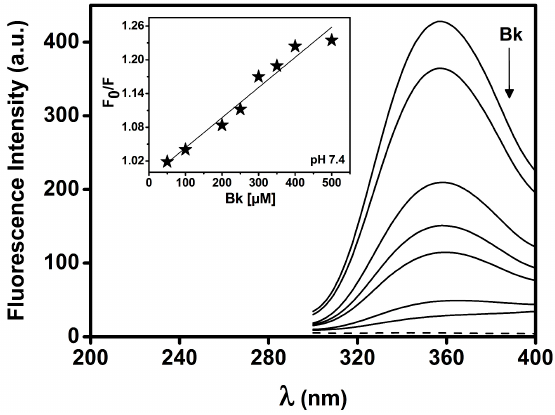
Figure 3. Fluorescence quenching of BTCI in complex with Bk at pH 7.4. Increasing concentrations of Bk (25 to 500 µM), indicated by arrow, lead to progressive reduction of Trp 82 fluorescence intensity of BTCI. The inset shows a Stern-Volmer plot to obtain the K sv values.